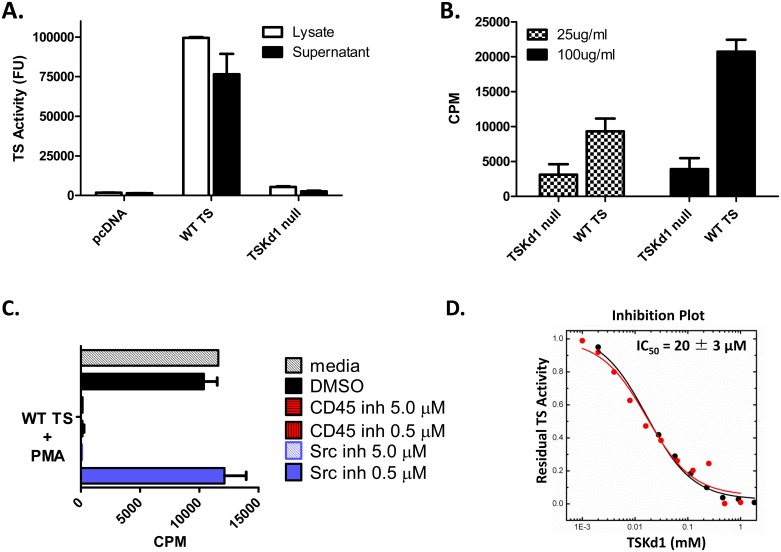
TS enzymatic activity is associated with costimulatory effects.In panel A, enzymatic activities of WT and TSKd1 mutant proteins were determined in lysates and supernatants of 293T cells transfected with WT TS and TSKd1 null DNA using fluorometric TS enzymatic activity assays. Panel B shows the co-stimulatory properties of WT rTS and TSKd1 null rTS on naïve CD8+ T cells. CD8+ T cells from naïve 4–5 week old BALB/c mice were purified by positive magnetic bead selection and incubated with suboptimal doses of PMA (12.5ng/ml) ± WT or TSKd1 null rTS. After 3 days, proliferation was measured by 3H-Thymidine incorporation. Shown are incorporated 3H-Thymidine counts per minute (CPM) above suboptimal PMA treatment alone. Similar TS costimulation assays using naïve CD8+ T cells were conducted with CD45 inhibitor PTP or Src-family kinase inhibitor PP2 added (C). In panel D, increasing concentrations of TSKd1 peptide were added to constant amounts of WT TS in TS enzyme assays. Results shown are representative of 2–4 independent experiments.